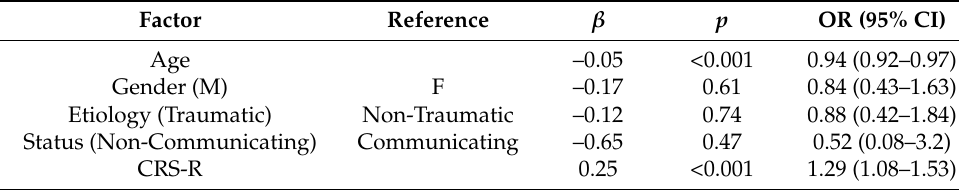
Table 8. Logistic regression model for 211 patients.